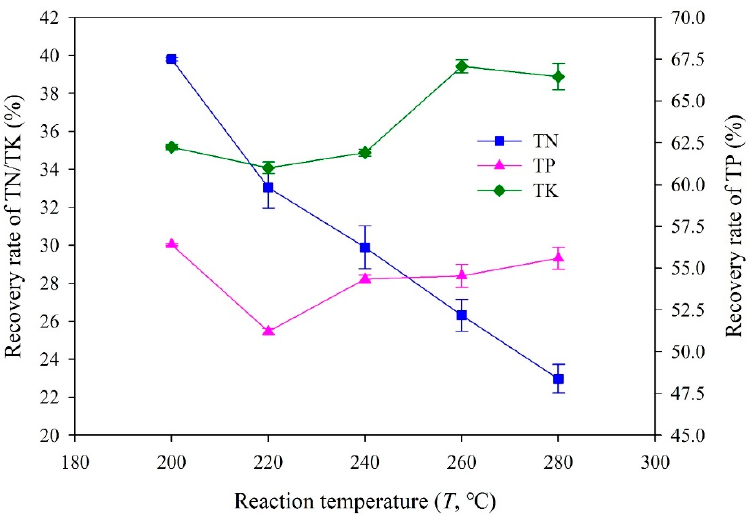
Figure 2. Recovery rate of nutrients in hydrochars obtained at different reaction temperatures.